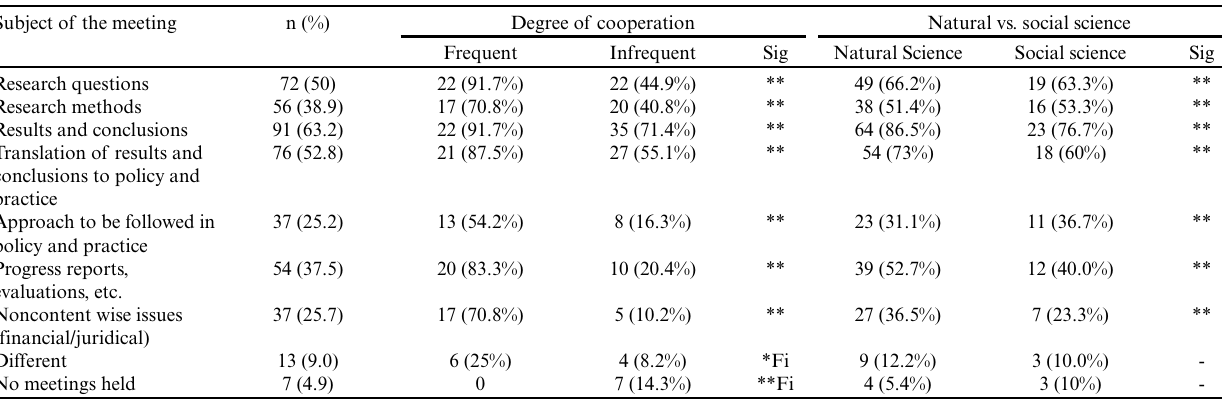
Table 3 . Research steps upon which collaboration took